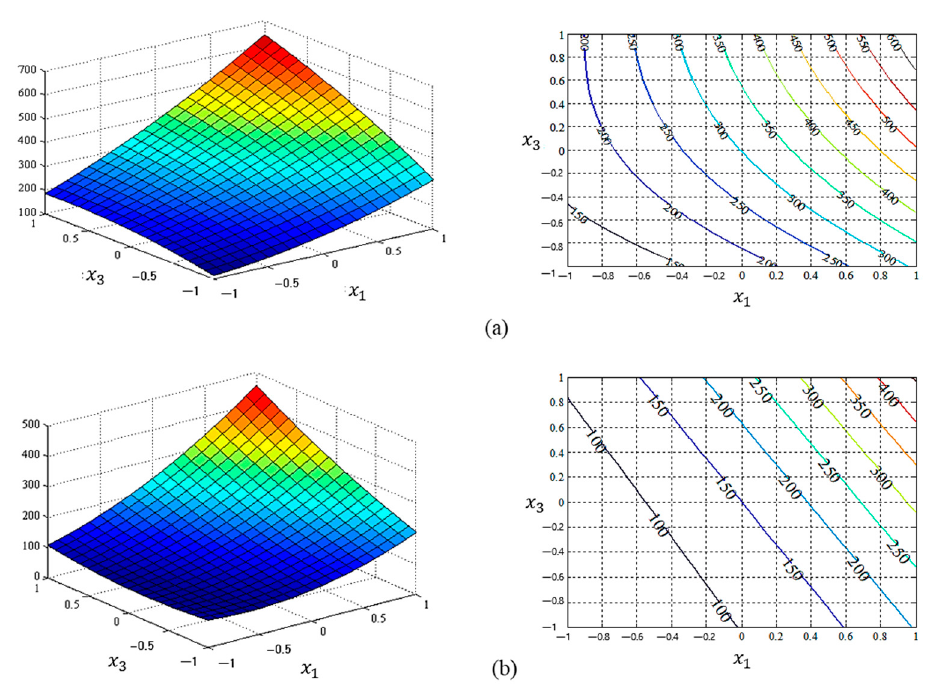
Figure A1. Graphical representation of the estimated mean response functions between x 1 and x 3 : ( a ) the response surface plot and response function of LSM; ( b ) the response surface plot and response function of NN.